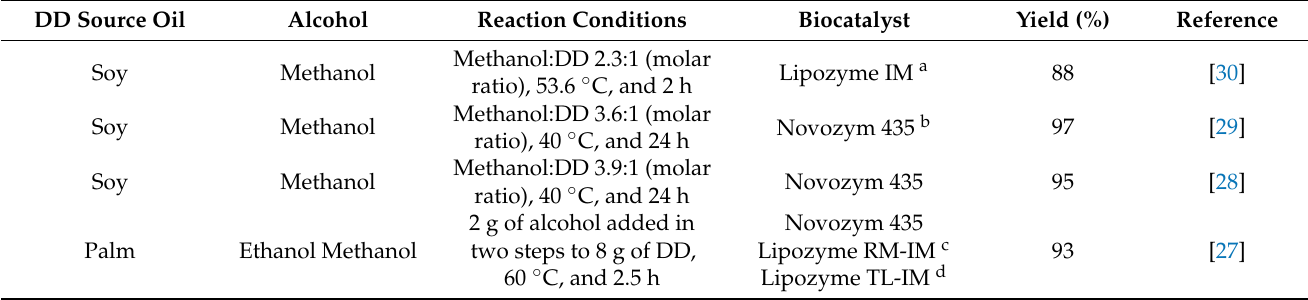
Table A2. Research focused on the production of biodiesel by the enzymatic route from deodorizer distillates (DD) of vegetable